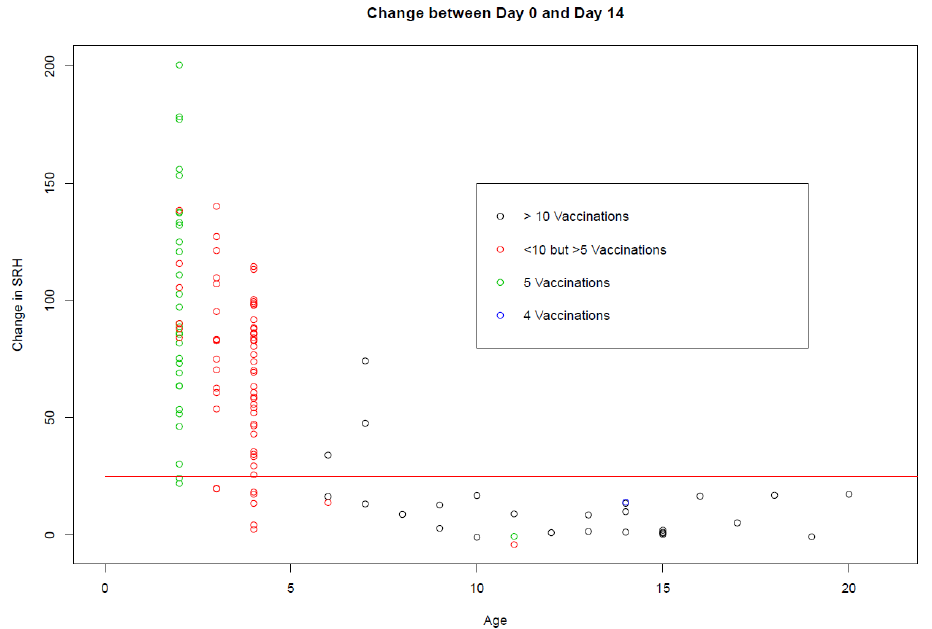
Figure 3. The change in SRH antibody titres between days 0 and 14 ( n = 123) by age is represented with a red horizontal line drawn at 25 mm 2 , as an increase of ≥ 25 mm 2 is considered significant (i.e., a seroconversion). The black circles represent the horses that received > 10 doses of vaccine, the red circles represent the horses that received < 10 but > 5 doses of vaccine, the green circles represent horses that received five doses of vaccine, and the blue circles represent horses that received four doses of vaccine. The Argentine horses were not included in the graph, as individual vaccination histories were not available. The number of vaccinations for the Japanese horses illustrated on the graph represent those recorded by the Japanese Racing Association (JRA). Vaccination history prior to JRA ownership was not available; thus, four Japanese horses that did not seroconvert and are represented on the graph as having received < 10 doses of vaccine may have actually received more than the number of doses recorded.